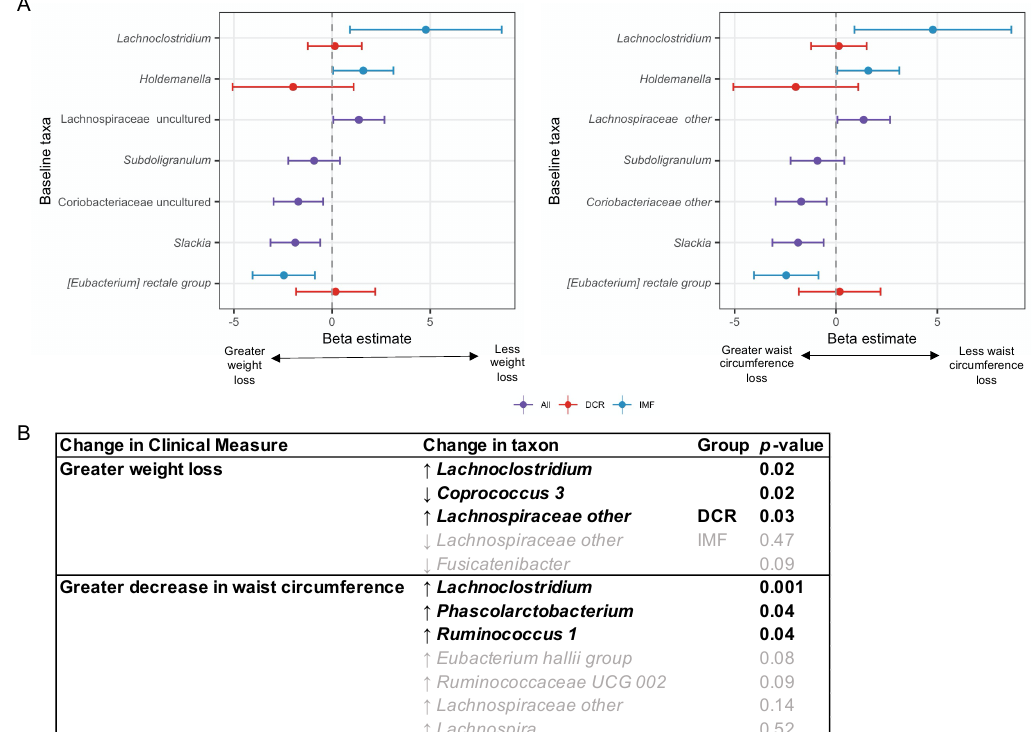
Figure 5. Associations between the gut microbiota and change in clinical health measures. ( A ) Abundance of the plotted genera were identified as the most predictive at baseline of percent change in weight and in waist circumference from baseline to three months using a random forest-based prediction method called VSURF ( n = 56). Linear regression modeling (controlling for age, sex, and intervention group, and evaluating the interaction between the taxon and intervention group) was used to help interpret the results. The forest plot shows regression estimates (x-axis) for one standard deviation change in the relative abundance of the taxon in models predicting percent change in the clinical measure. Lower beta values indicate that greater abundance of the taxon correlate with greater decreases in the clinical measure and vice versa. Some of the selected taxa show different relationships with the outcomes among DCR (red) versus IMF (blue). For example, greater abundance of Subdoligranulum was associated with greater weight loss among IMF but not among DCR. Some selected predictors do not show statistically significant linear relationships with change in the clinical measure, but they may interact with each other in complex ways in relation to the outcome. “Other” genera indicate sequences that could only be classified to the family-level. ( B ) Change in the abundance of the shown taxa from baseline to three months were identified as the most predictive of percent change in weight and in waist circumference from baseline to three months using a random forest-based prediction method called VSURF ( n = 52). Linear regression modeling (controlling for age, sex, and intervention group, and evaluating the interaction between the taxon and intervention group) was used to help interpret the results. Lachnospiraceae other showed a different relationship with percent weight loss among DCR versus IMF, with increases in abundance associated with greater weight loss only among DCR. While some selected predictors do not show statistically significant linear relationships with change in the clinical measure (shown in grey), these selected taxa may interact with each other in complex ways in relation to the outcome. “Other” genera indicate sequences that could only be classified to the family-level. MetS: Metabolic syndrome; HDL: High density lipoprotein; DCR: Daily caloric restriction; IMF: Intermittent